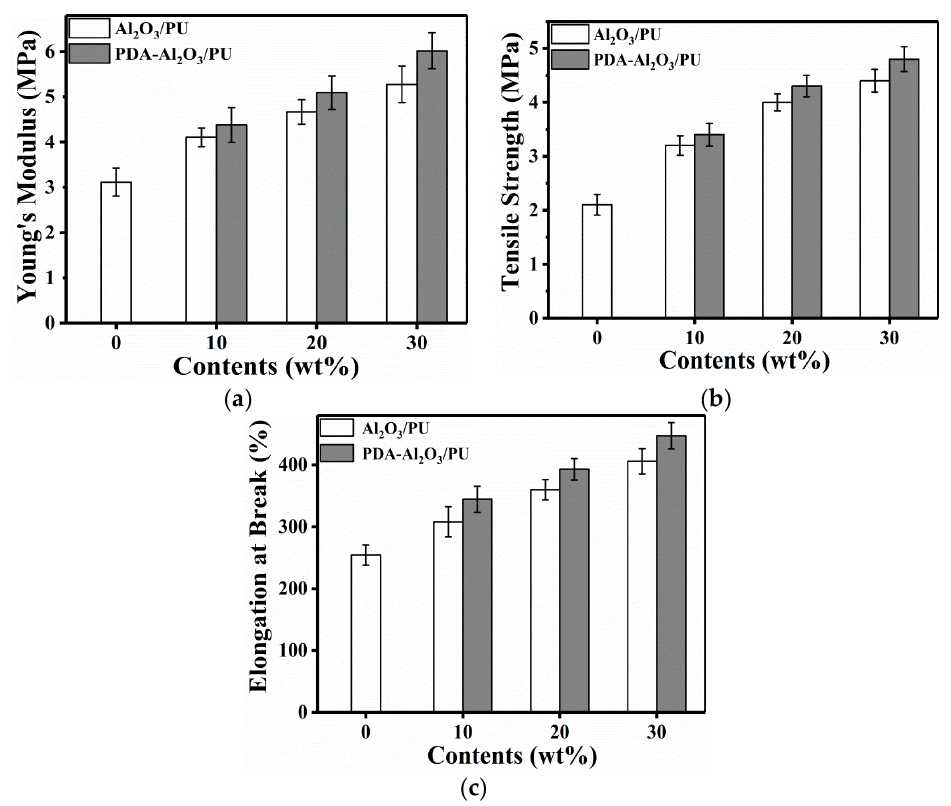
Figure 11. Mechanical properties of the Al 2 O 3 /PU and PDA-Al 2 O 3 /PU composites: ( a ) Young’s modulus, ( b ) tensile strength, and ( c ) elongation at the break.